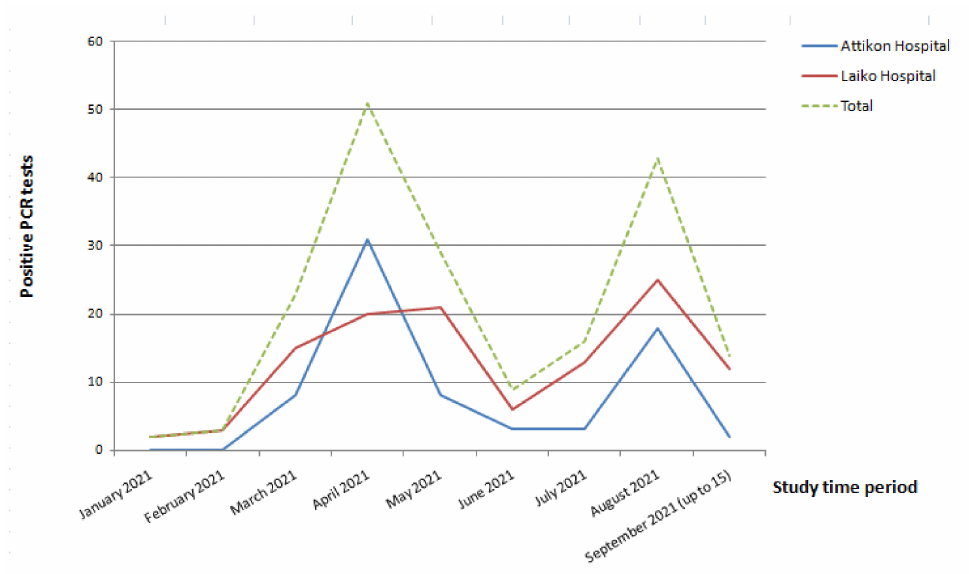
Figure 1. Severe Acute Respiratory Syndrome Coronavirus-2 (SARS-CoV-2) infection rate per month among vaccinated and unvaccinated Health-Care-Workers (HCWs) in two Academic Hospitals in Athens, Greece, during the study